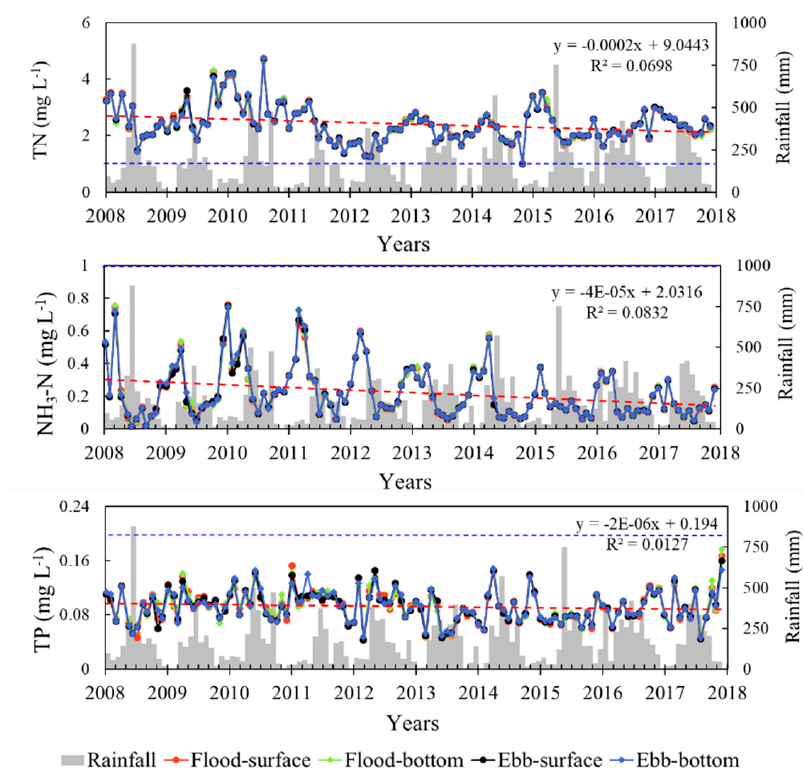
Figure 3. Temporal changes in total nitrogen (TN), ammonia nitrogen (NH 3 –N), and total phosphorous (TP) in estuarine water measured from six sites (given as mean) in Nansha, Guangzhou, over the ten-year period (2008–2017). Rainfall data are presented as background information. The red dashed lines refer to the trendlines with equations and R 2 provided. The blue dashed lines refer to the Chinese environmental quality Class III standards for surface water.